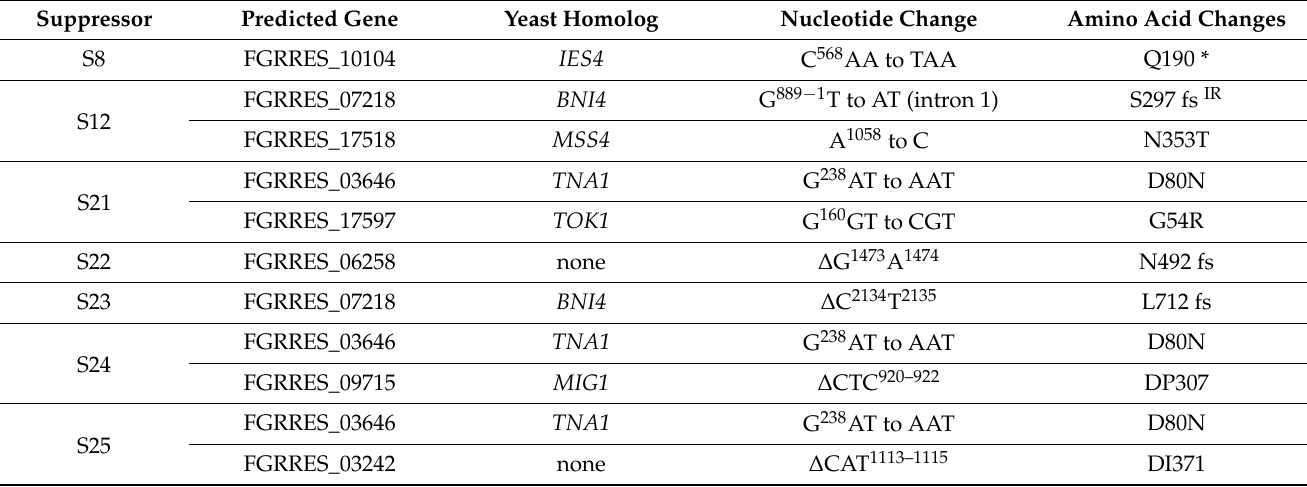
Table 3. Mutations identified in suppressor strains of Fgyck1 mutant by whole genome sequencing.